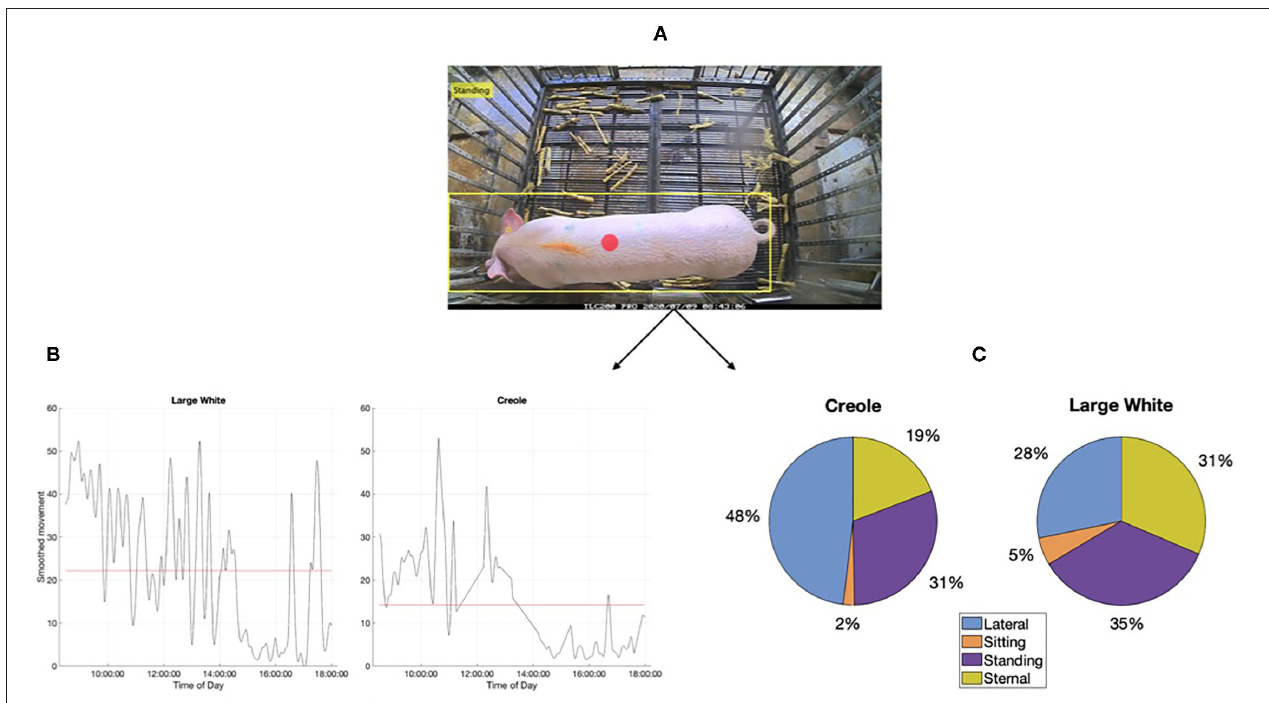
FIGURE 2 | (A) Example of detection using CNNs. The first CNN, based on Yolo v2, detects the pig. Here we drew a yellow rectangle around the pig based on the detection. We then computed the center of gravity of the pig, and drew the red disk. The second CNN, based on the GoogleNet architecture, estimate the pig’s posture, which is shown on the top left part of the image. (B) Examples of pig’s movement over time. The movement is the distance, in cm, between the pig’s center of gravity on two successive images. The movement is then smoothed using smoothing splines. The examples are shown for a Large White and Creole pigs on August 22, 2020. The red line is the daily average distance. (C) Posture distribution of the Creole and Large White pigs. We used the estimated posture of all pigs during the whole monitoring period to estimate the posture distribution of each